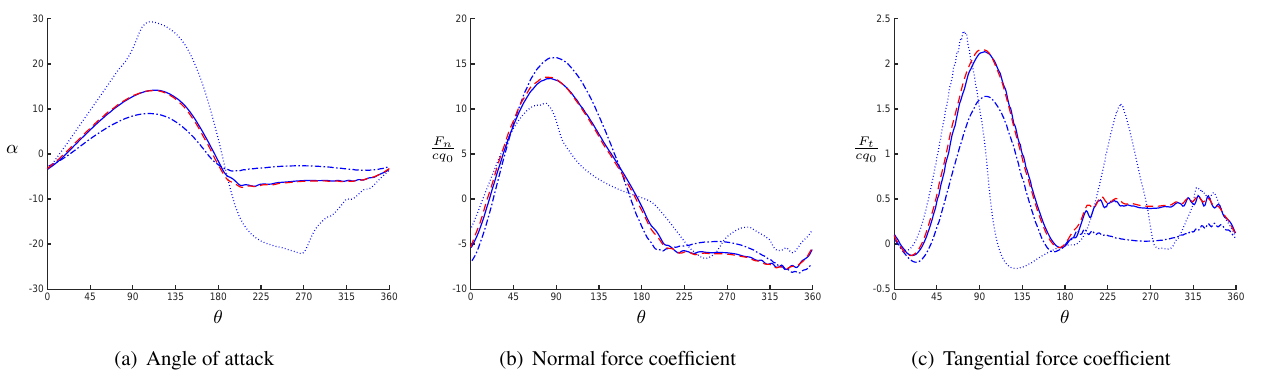
Figure 3. H-type VAWT with AR = 1 . 5: evolution of the angle of attack and of the normal, F n / ( cq 0 ), and tangential, F t / ( cq 0 ), force coefficients at mid-span versus the blade angular position θ at TSR = 2 . 14 (dotted), 3 . 21 (solid), and 4 . 28 (dash-dotted); an intermediate resolution ( D/h = 48) result for TSR = 3 . 21 is also shown (dash).